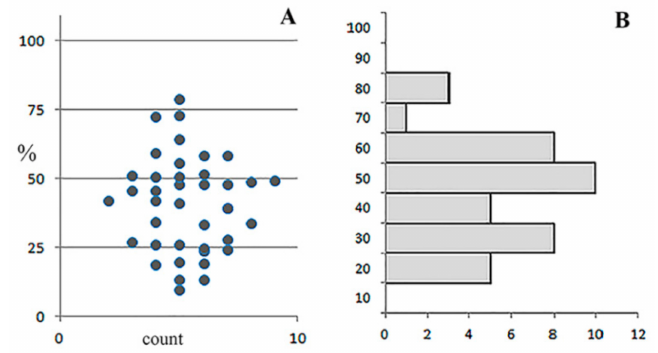
Figure 7. Representation of immunopositive M. tuberculosis on 5 µ m-thick slices and 20 µ m-thick optical sections, produced from the same preparations. ( A ) Number of visible bacteria on 5 µ m optical sections, normalized to overall 20 µ m slices. Each point represents one optical section (500 µ m 2 ). ( B ) Ranging histogram, representing variability of the section with high and low bacteria density. The abscissa shows number of observations; the ordinate shows a number of bacteria, % from the 20 µ m sample.